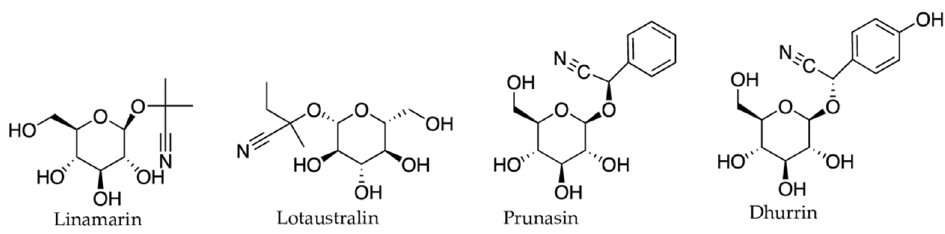
Figure 4. Examples of widely distributed cyanogenic glycosides in plant